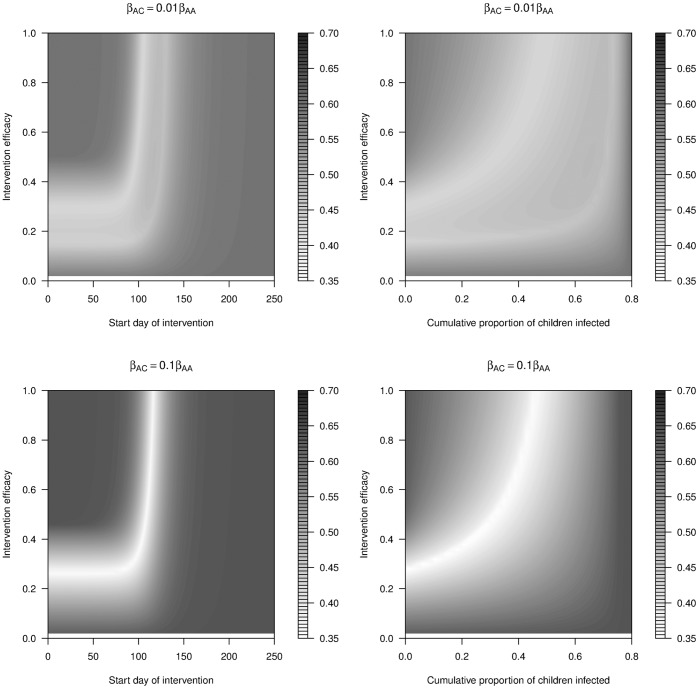
Cumulative attack rate of the whole population (CAW) under long intervention with different levels of efficacy against different time trigger (the start day of intervention, left column) and population trigger (cumulative proportion of children infected, right column).βAC = 0.01 * βAA; βCA = 0.01 * βCC (upper row); βAC = 0.1 * βAA; βCA = 0.1 * βCC (lower row). R0A = 1.25, R0C = 2; 50% adults; 50% children (similar patterns were observed in populations with different proportions of adults and children, not shown); long intervention; interrupt all routes of transmission. All other parameters and initial conditions are listed in Tables 1 and 2. The data ranged from intervention efficacy of 0.02 to 1 with intervals of 0.02. This explains why there was no colour in the contour plots from intervention efficacy 0 to 0.02. Note that beyond a threshold level of 0.8, the intervention was not triggered, as CAAA never reached 0.8 even in the absence of any intervention.